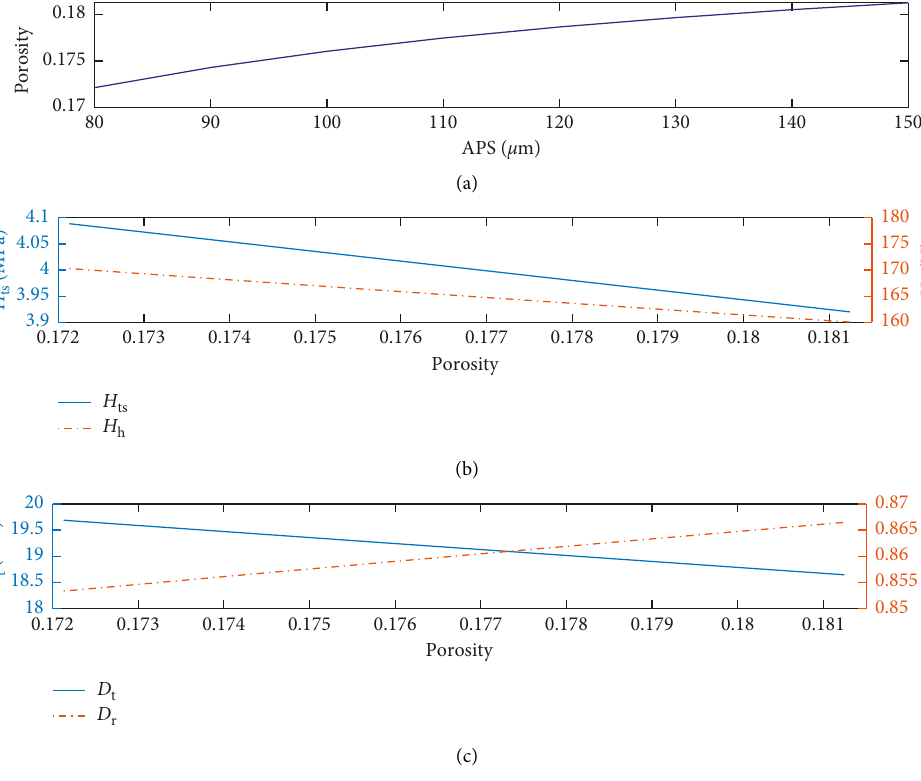
Figure 12: The experimental results for tabletting: the influences of